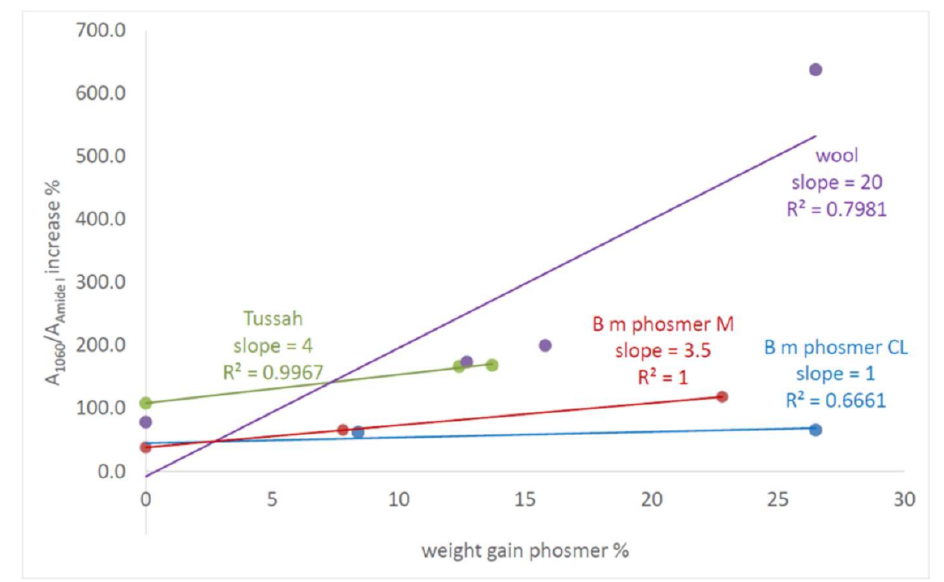
Figure 16. Trend of the A 1060 /A Amide I IR absorbance ratio increase % after 7 days immersion in the SBF solution, as a function of the weight gain % after phosmer grafting.